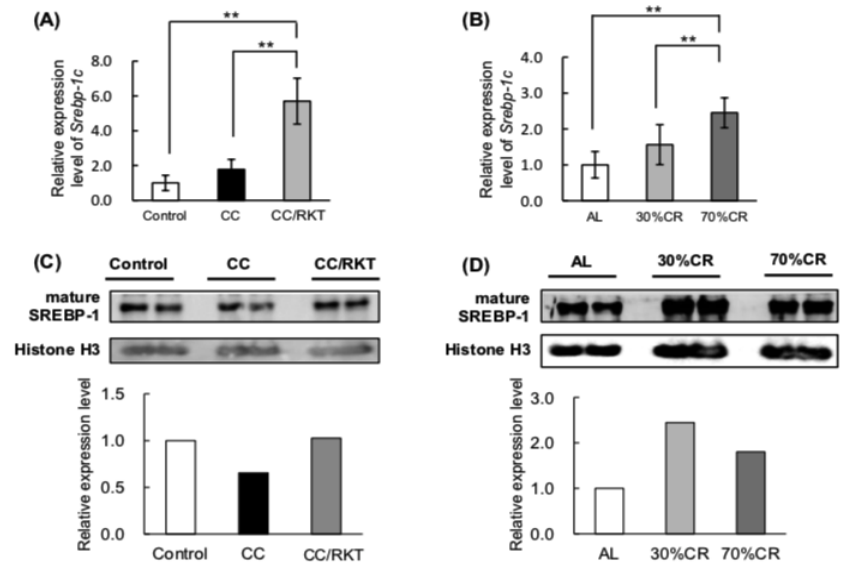
Figure 4. Effects of cancer cachexia (CC), rikkunshito (RKT), and caloric restriction (CR) on the expression of Srebp-1c mRNA and the mature active form of SREBP-1 protein in epididymal white adipose tissue (eWAT). To measure Srebp-1 c mRNA by real-time RT-PCR, total RNA was extracted from the eWAT of ( A ) control, CC, and CC/RKT rats, and ( B ) rats fed ad libitum (AL) and subjected to CR. Srebp-1 c mRNA levels were normalized to Tbp mRNA expression. Error bars represent the SD associated with each mean ( n = 5–6). ** p < 0.01 by Tukey’s test. Western blot analysis of SREBP-1 was performed using a chemiluminescence method. ( C , D ) Image of a western blot for the mature form of SREBP-1. Pooled nuclear extracts from the eWAT of three ( C ) control, CC, or CC/RKT rats, and ( D ) AL or CR rats were used in each lane, resultantly pooled nuclear extracts from total six rats were analyzed. Densitometry data for SREBP-1 protein were normalized to data for histone H3 protein.